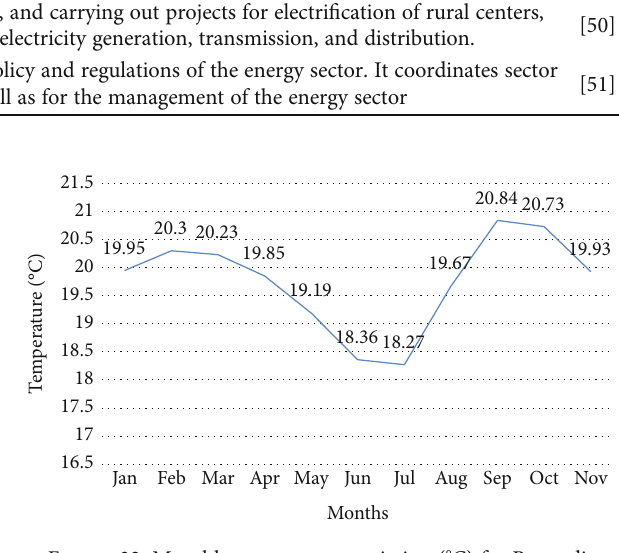
32: Monthly temperature variation ( ° C) for